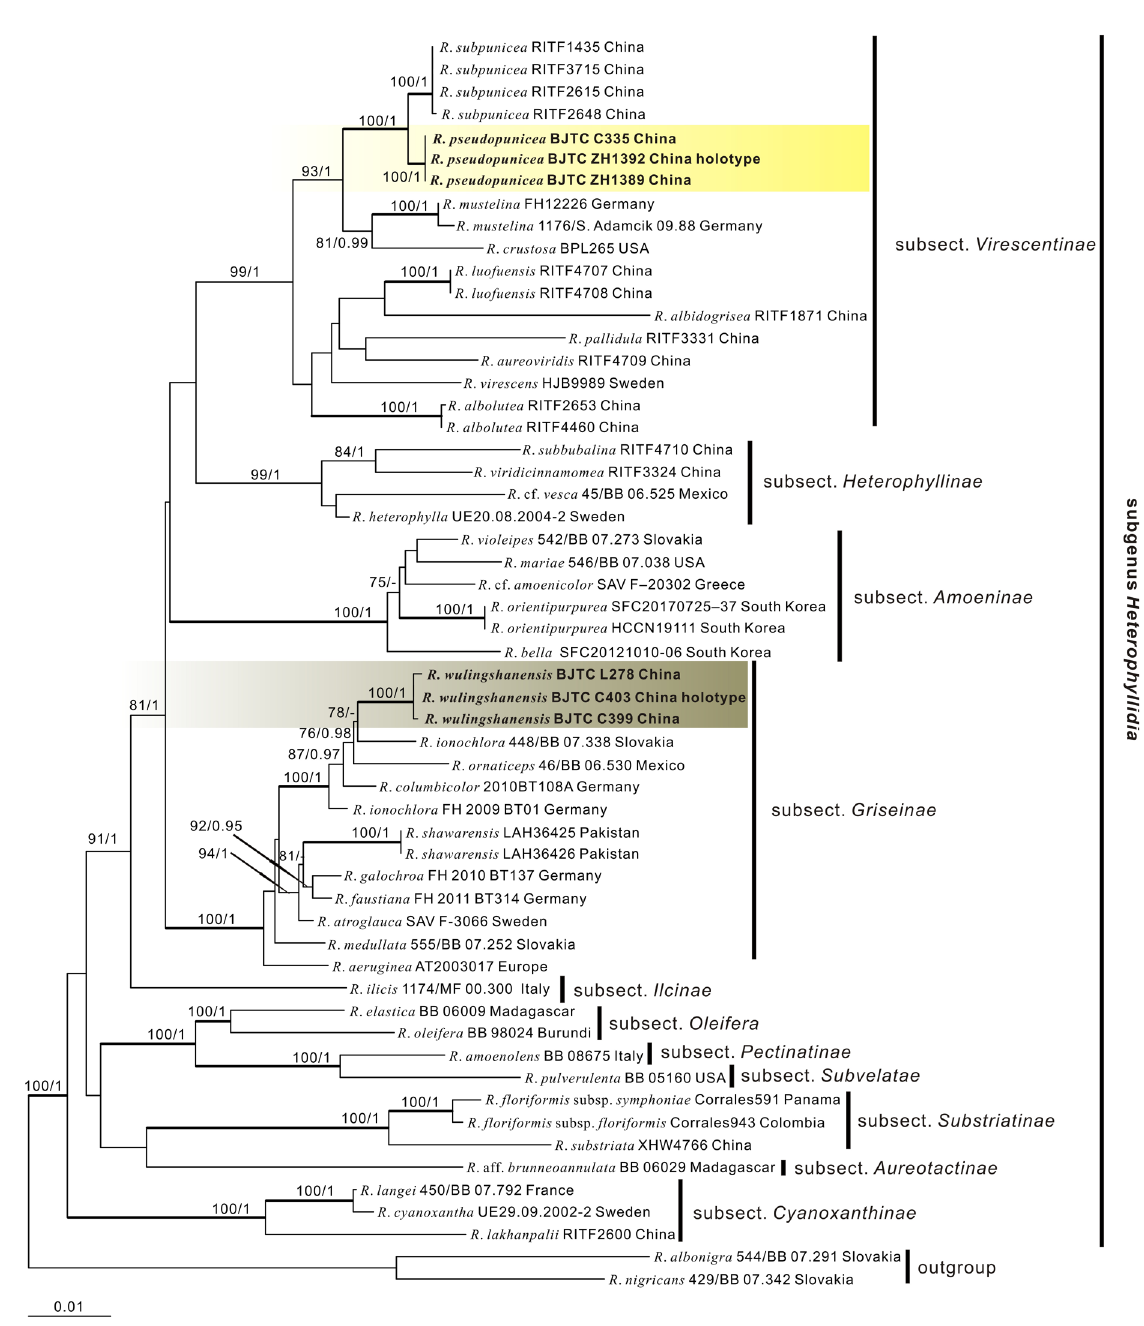
Fig. 1. Maximum likelihood (ML) phylogenetic tree inferred from nrLSU -rpb2- mtSSU. The two new species described in this paper are indicated in bold . Values next to nodes indicate ML bootstrap values (left) and Bayesian posterior probabilities (right). Only ML bootstrap values ≥ 70% and Bayesian posterior probabilities ≥ 0.95 are